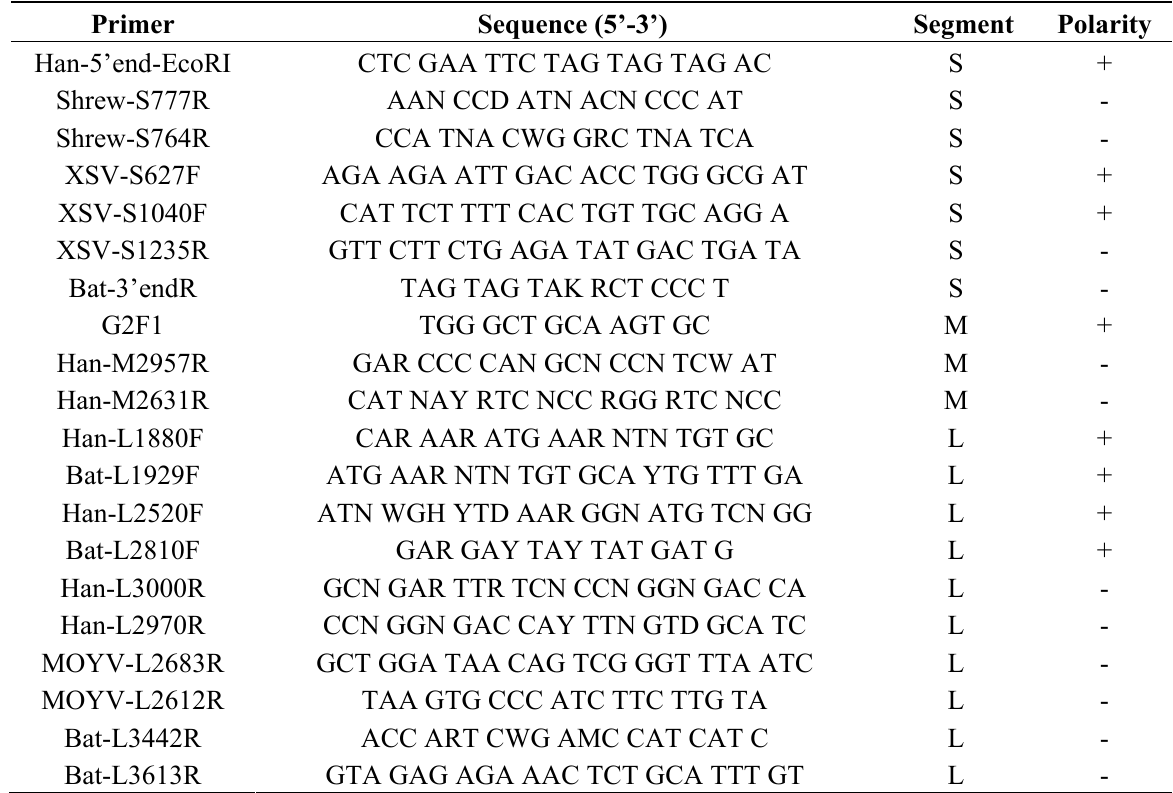
Table 3. Oligonucleotide primers used to amplify Xuan Son virus and Mouyassue virus from insectivorous bat